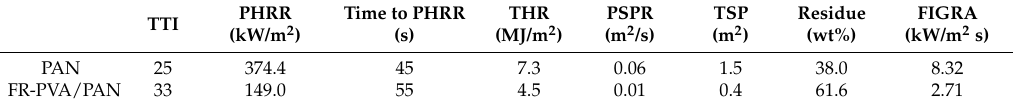
( d ) total smoke production (TSP) curves of PAN and FR-PVA/PAN. Table 5. Parameters of PAN and FR-PVA/PAN obtained from cone calorimetry test. Table 5. Parameters of PAN and FR-PVA/PAN obtained from cone calorimetry test. TTI